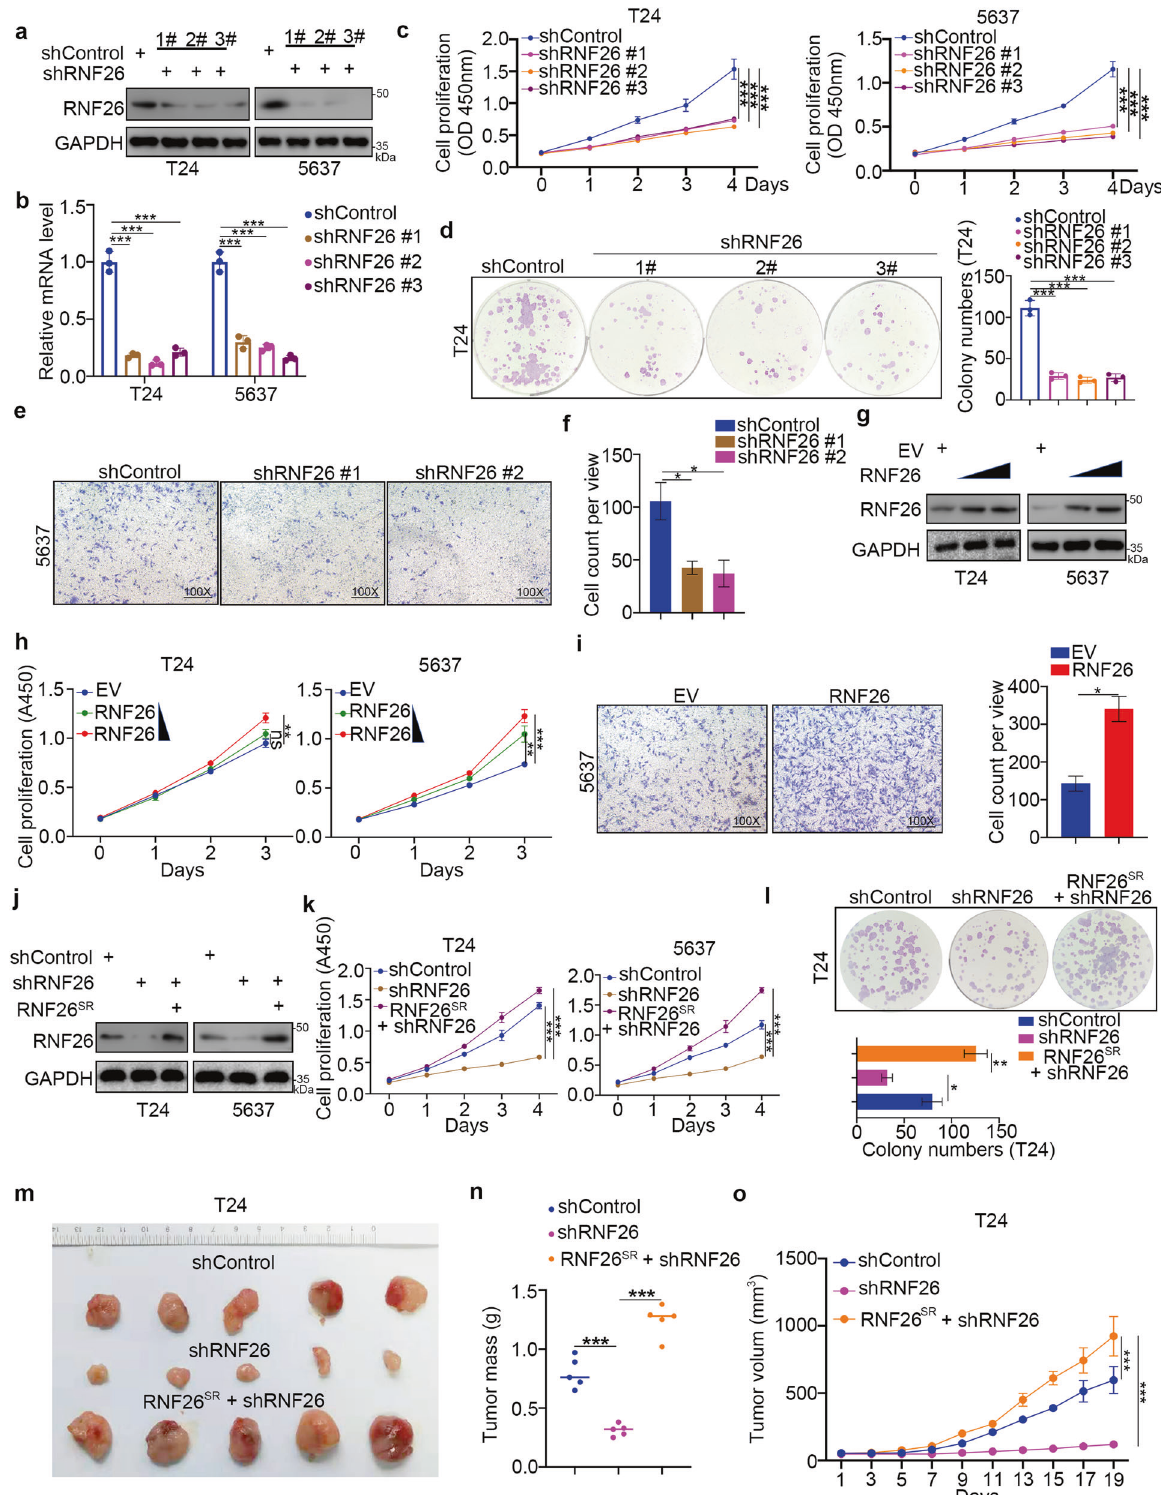
Fig. 2 RNF26 promotes the proliferation and invasion of bladder cancer cells. a – f T24 and 5637 cells were infected with shControl or shRNF26 for 72 h. After puromycin selection, cells were harvested for western blot analysis ( a ), RT-qPCR analysis ( b ), CCK-8 assay ( c ), colony formation assay ( d ), and transwell assay ( e ). Data present as mean ± SD with three replicates. * P < 0.05; *** P < 0.001. g – i T24 and 5637 cells were transfected with indicated plasmids. Forty-eight hours post transfection, cells were collected for western blot analysis ( g ), CCK-8 assay ( h ), and transwell assay ( i ). Data present as mean ± SD with three replicates. Ns not signi fi cant; * P < 0.05; ** P < 0.01; *** P < 0.001. j – o T24 and 5637 cells were infected with indicated constructs for 72 h. After puromycin selection, cells were harvested for the western blot analysis ( j ), CCK-8 assay ( k ), colony formation assay ( l ), and subcutaneous xenografts assay ( m – o ). For k and l , data present as mean ± SD with three replicates. * P < 0.05; ** P < 0.01; *** P < 0.001. For m – o , data present as mean ± SD with fi ve replicates. *** P < 0.001. Cell Death and Disease (2021)